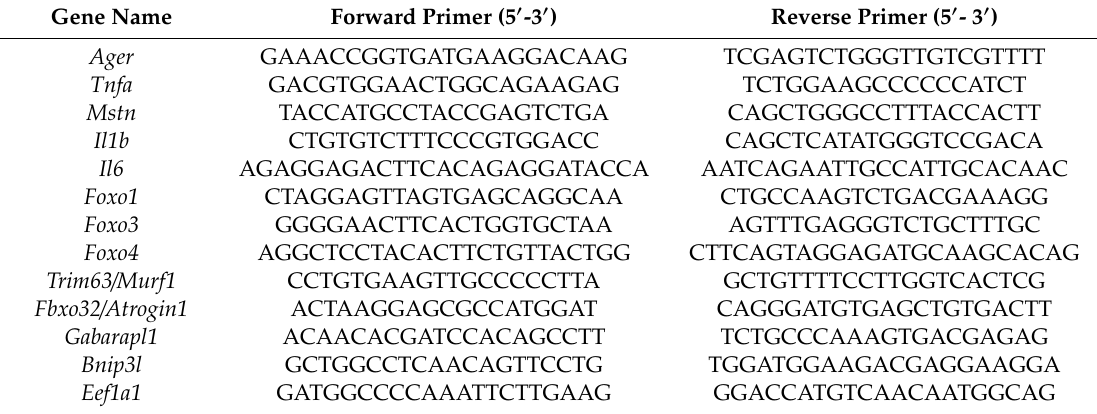
Table 2. List of the nucleotide sequence of gene-specific